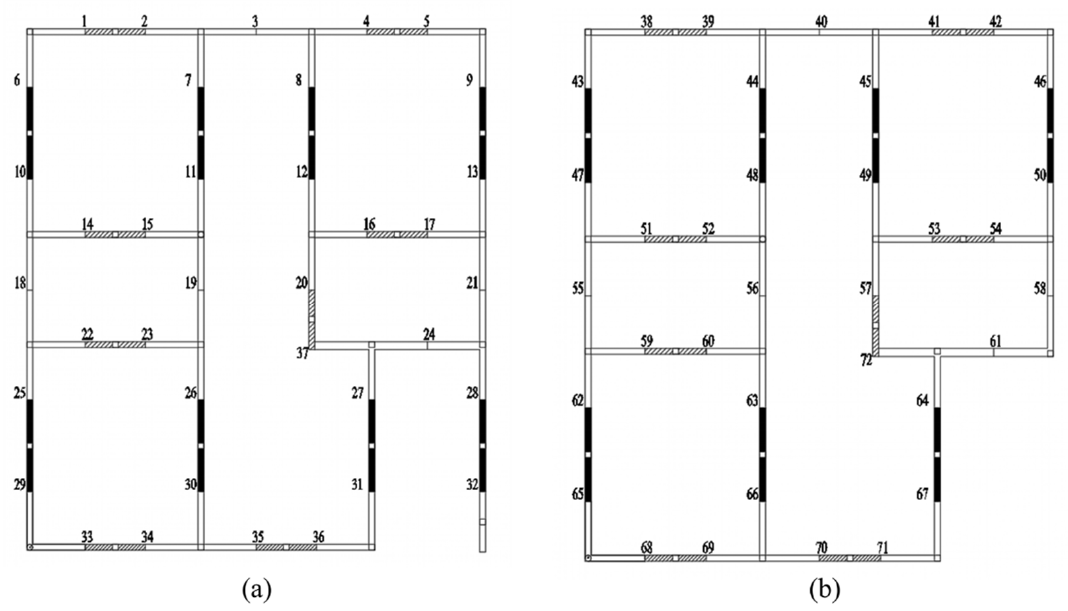
joints (welded connection of steel plates) of each prefabricated cantilever component were numbered as shown in Figure 14.